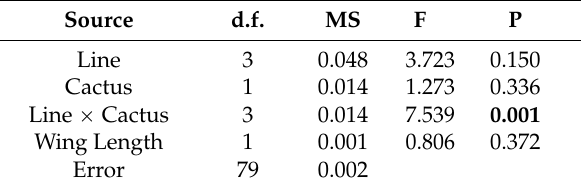
Table 2. Analysis of variance testing for differences in ovariole number in D. buzzatii . Source d.f.